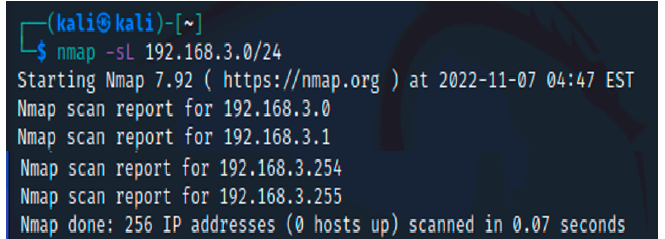
Figure 14. Nmap scan with -sL command after solving the issues.